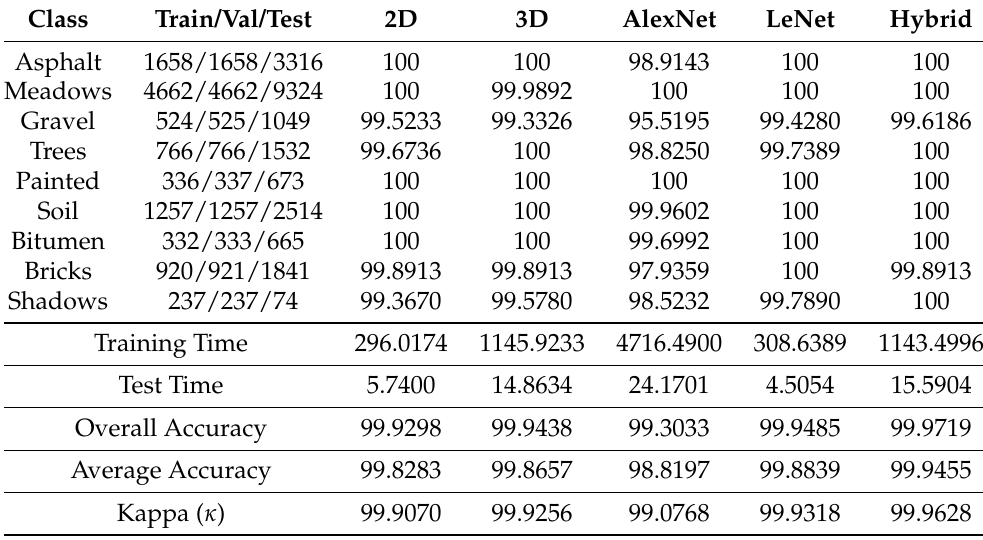
Table 2. Pavia University: Performance analysis of different state-of-the-art models trained using regularization technique.